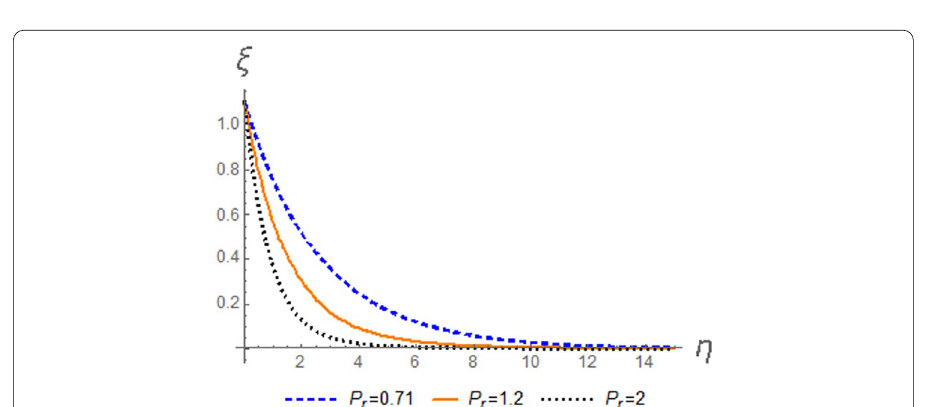
Fig. 9 Effect of P r on the temperature